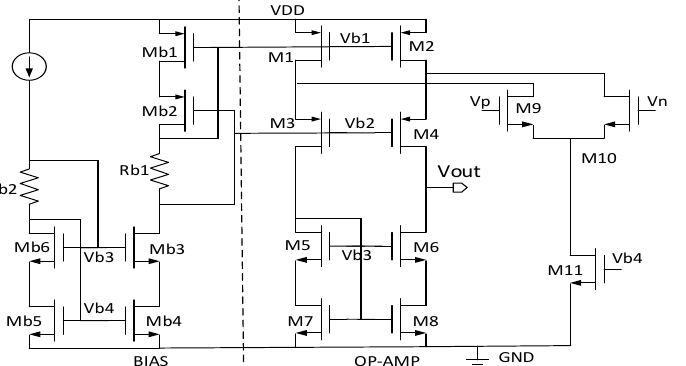
Figure 5. Operational amplifier design. M1–11, b1–b6 are MOSFETs; vb1–4 are bias voltage; vp, vn are inputs.